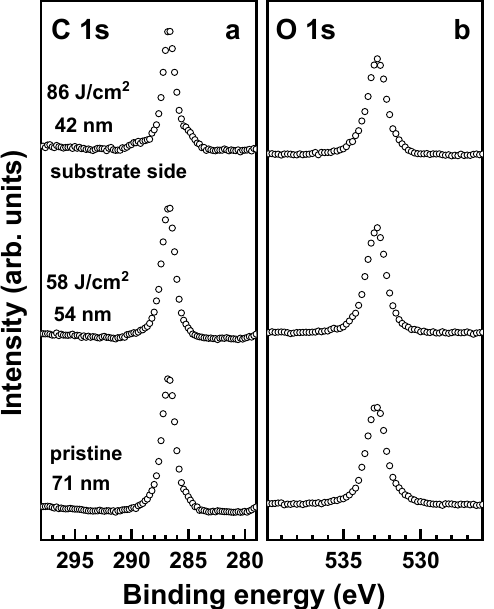
Figure 10. C 1s ( a ) and O 1s ( b ) XP spectra of the pristine and irradiated (UV light) PEG films deposited on Au substrate. The dose and thickness are given in the respective spectra. The bottom and middle spectracorrespond to the top side of the film facing the ambient, whereas the top spectra represent the side of the film facing the substrate. The irradiated film was turned around for the latter measurement. The bottom and middle spectra are reprinted with permission from Ref. [18].